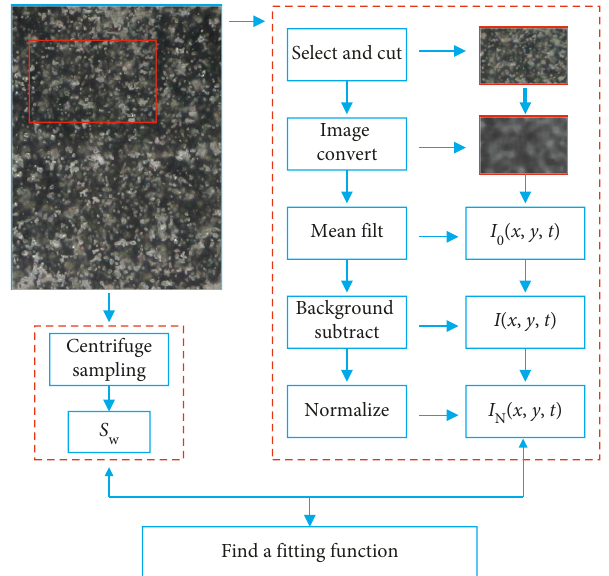
Figure 4: The procedure of calibration